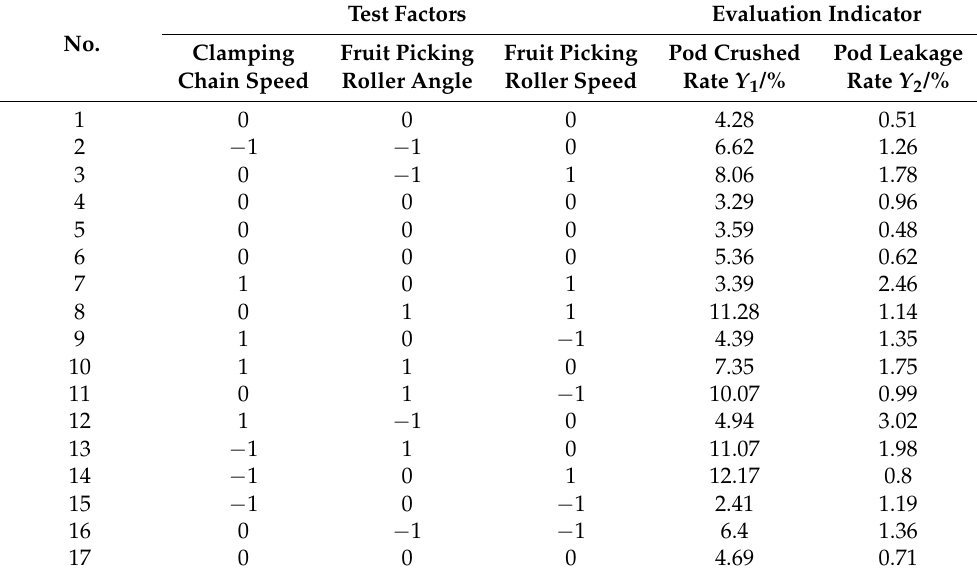
Table 5. Results of the multi-factor